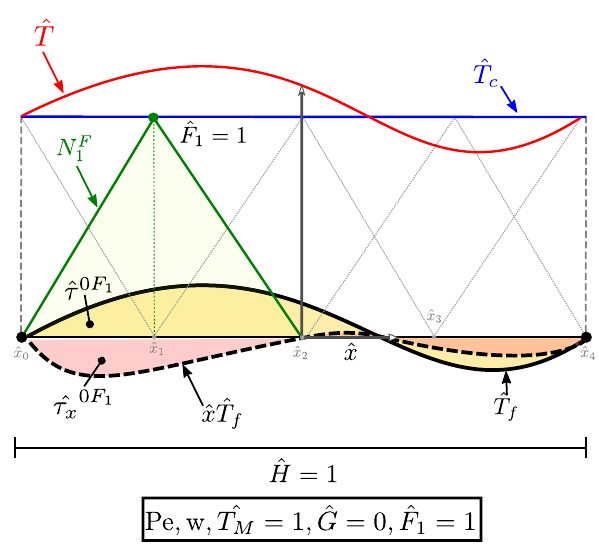
Fig. 4 The functions to be evaluated offline in an RVE. It considers the case i = 1 for a discretization of np = 5 for the source. For a given Pe and w, and additionally to the cases presented in Fig. 2, np RVE problems must be computed. The integral ˆ τ 0 F i and the first moment ˆ τ x 0 F i of the fine solution ˆ T f are stored in the